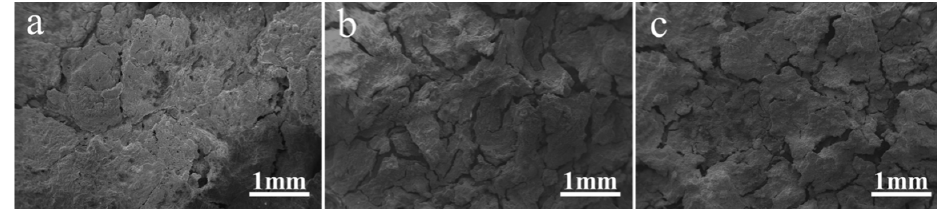
Figure 7. The morphologies of discharge products on ( a ) pure Mg, ( b ) IC30, and ( c ) IC33 during discharging in 3.5% NaCl solution at 30 mA cm − 2 .